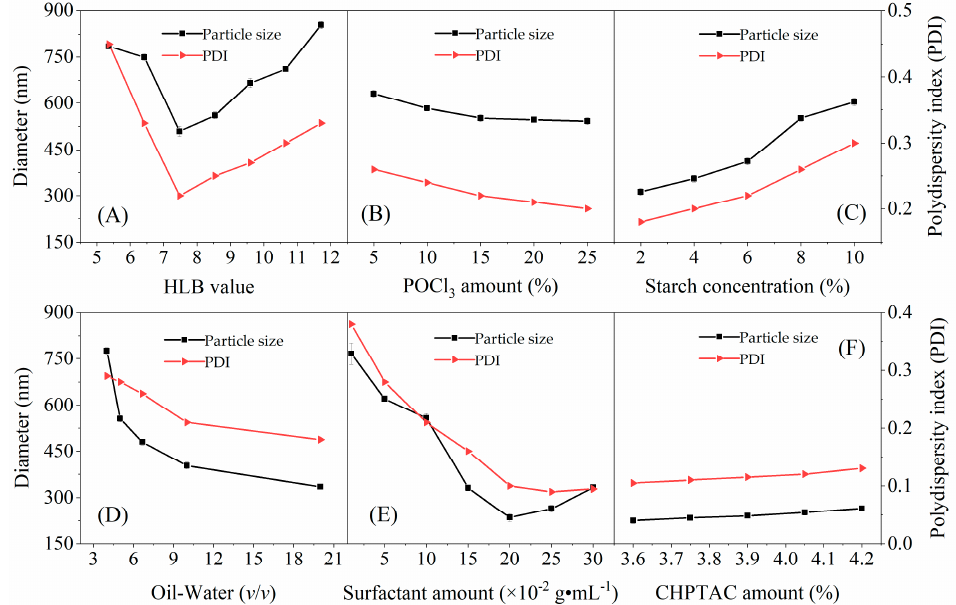
Figure 1. Effects of ( A ) HLB value (at a POCl 3 amount of 15 wt %, an aqueous starch concentration of 6.0 wt %, an oil–water ratio of 10:1 ( v/v ), a surfactants total amount of 0.15 g · mL − 1 , and a CHPTAC amount of 3.9 wt %); ( B ) POCl 3 amount (at a HLB value of 7.48, an aqueous starch concentration of 6.0 wt %, an oil–water ratio of 10:1 ( v/v ), a surfactants total amount of 0.15 g · mL − 1 , and a CHPTAC amount of 3.9 wt %); ( C ) starch concentration (at a HLB value of 7.48, a POCl 3 amount of 15 wt %, an oil–water ratio of 10:1 ( v/v ), a surfactants total amount of 0.15 g · mL − 1 , and a CHPTAC amount of 3.9 wt %); ( D ) oil–water ratio (at a HLB value of 7.48, a POCl 3 amount of 15 wt %, an aqueous starch concentration of 6.0 wt %, a surfactants total amount of 0.15 g · mL − 1 , and a CHPTAC amount of 3.9 wt %); ( E ) surfactant amount(at a HLB value of 7.48, a POCl 3 amount of 15 wt %, an aqueous starch concentration of 6.0 wt %, an oil–water ratio of 10:1 ( v/v ), and a CHPTAC amount of 3.9 wt %); ( F ) CHPTAC amount (at a HLB value of 7.48, a POCl 3 amount of 15 wt %, an aqueous starch concen- tration of 6.0 wt %, an oil–water ratio of 10:1 ( v/v ), and a total surfactants amount of 0.20 g · mL − 1 ) on the CA-CSNPs particle size and the polydispersity index (PDI). All reactions were performed at 40 ◦ C for 2